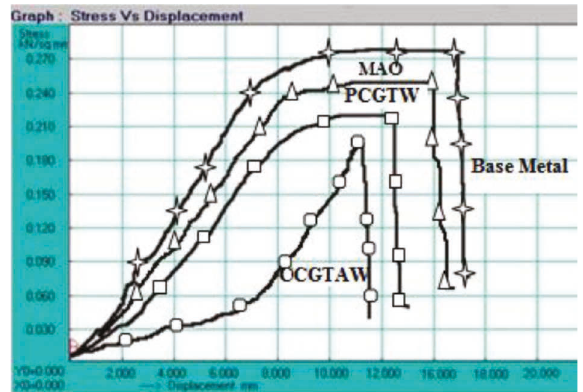
Figure 4: Load Displacement curves recorded during the tensile test.